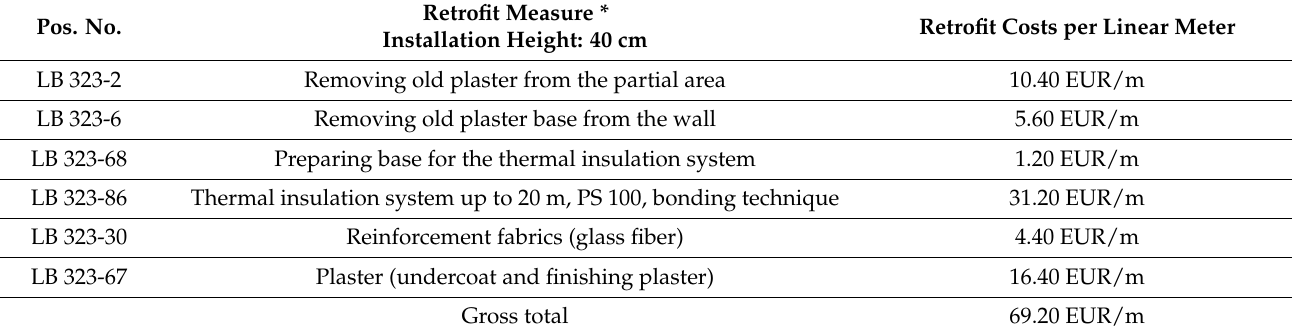
Table A18. Retrofit components and costs of the thermal bridge retrofit of a window lintel [38,39]. Pos.